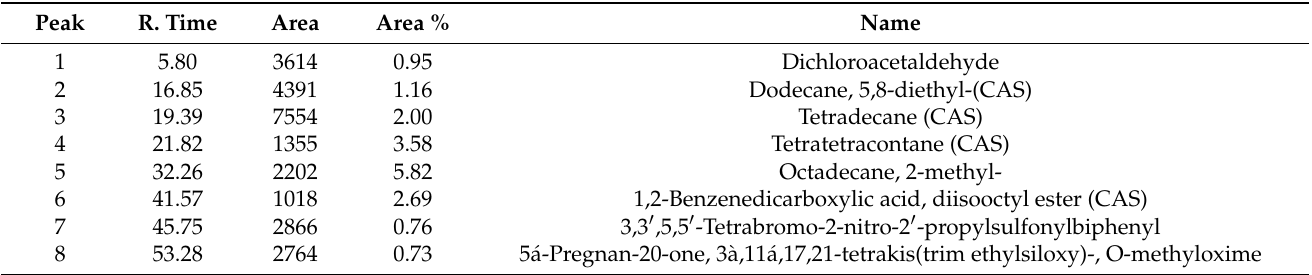
Table 3. GC–MS analysis of R. damascena callus in the citric acid treatment.